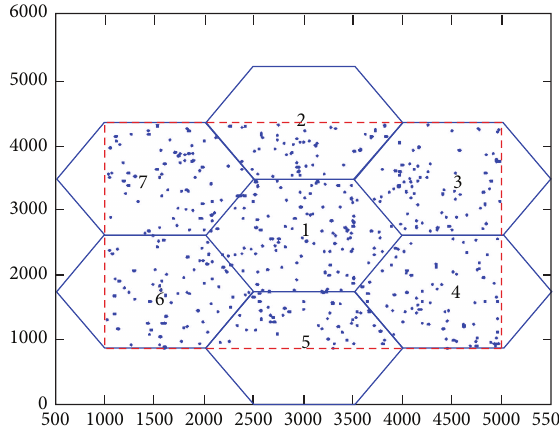
Figure 6: Simulation environment.